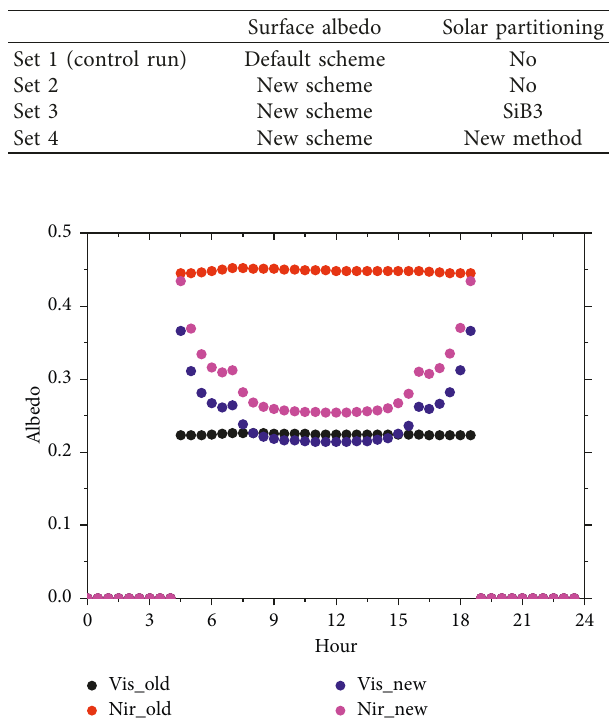
Figure 2: Comparison of the annual averaged diurnal cycle of the visible and near-infrared surface albedoes between the default and the new surface albedo parameterization schemes.